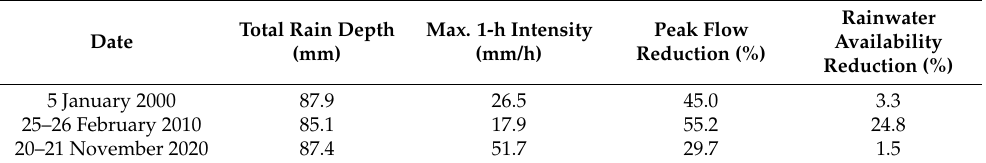
Table 5. Peak flow reduction and rainwater availability reduction achieved by applying the optimized controlled release policy on each rain